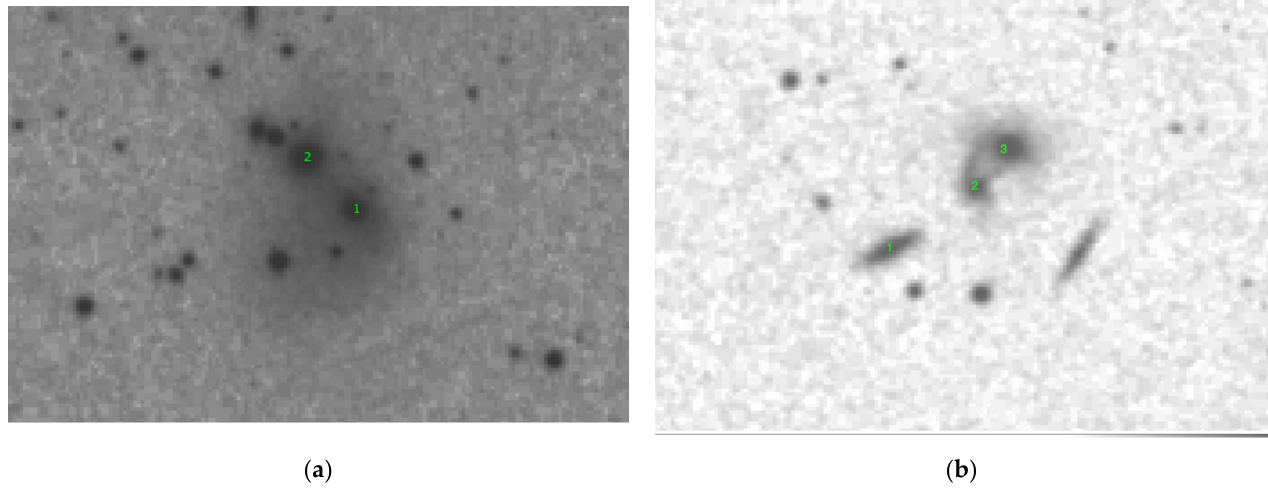
Figure 5. ( a ) DSS image of HCG 94 with X-ray point sources. ( b ) DSS image of HCG 95 with X-ray point sources.